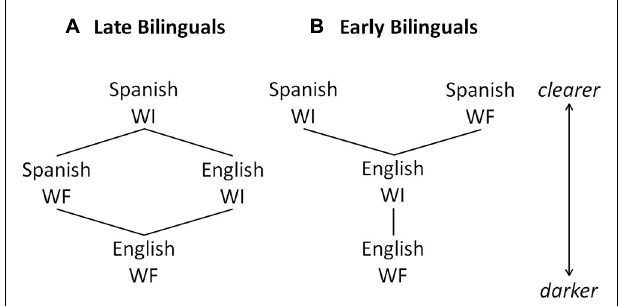
FIGURE 7 | Schematic of /l/ clearness by language and context for Late (A) and Early (B) Bilinguals.